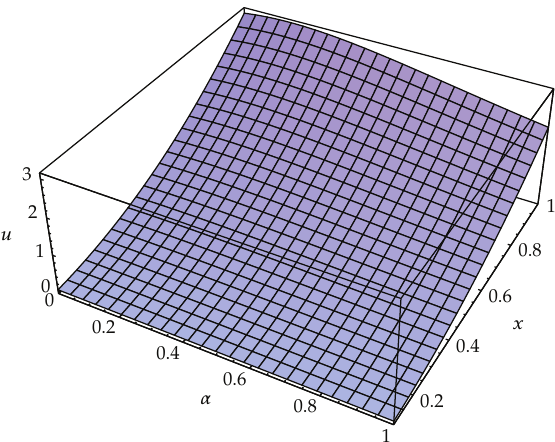
Figure 4: The surface of second-order approximate solution of (cid:2) 3.12 (cid:3) when t (cid:9) 0 . 8, β (cid:9)